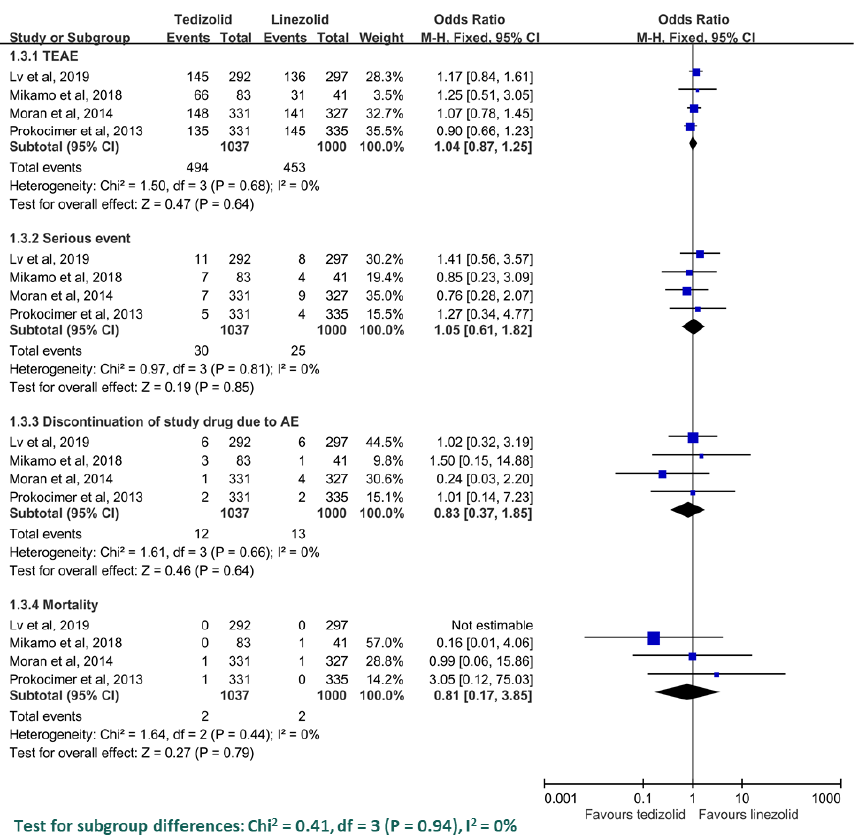
Figure 5. The risk of an adverse event with tedizolid and linezolid.